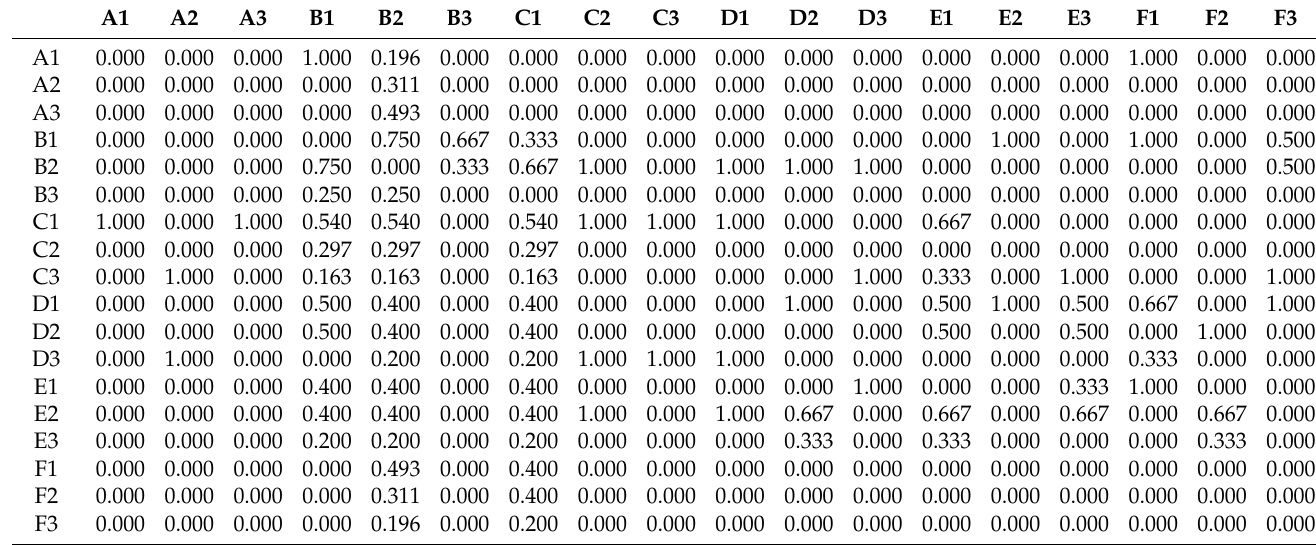
Table A2. The unweighted super-matrix.